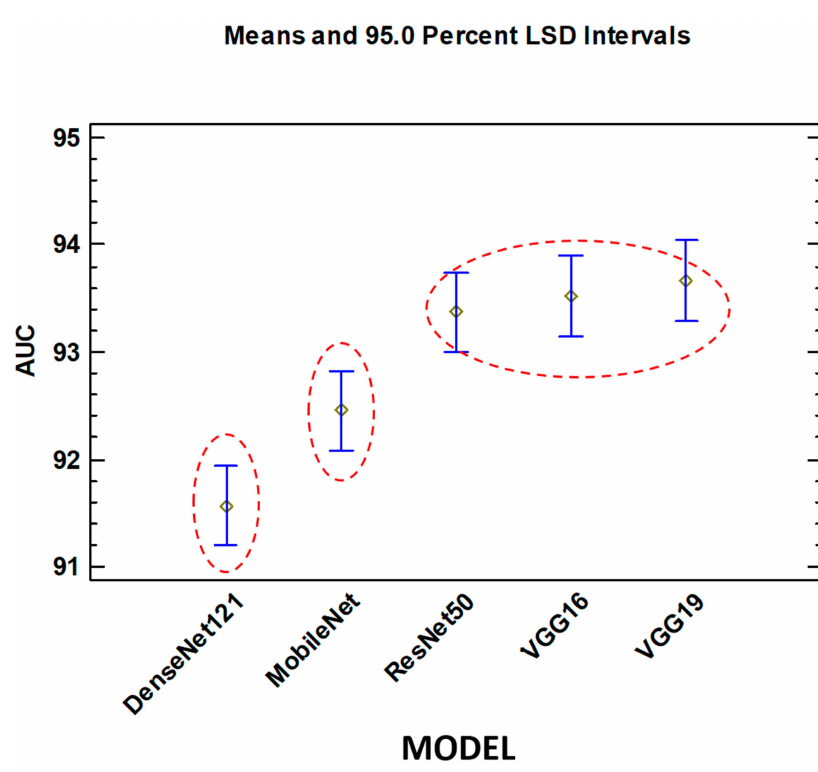
Figure 4. Multiple Range Tests for variable